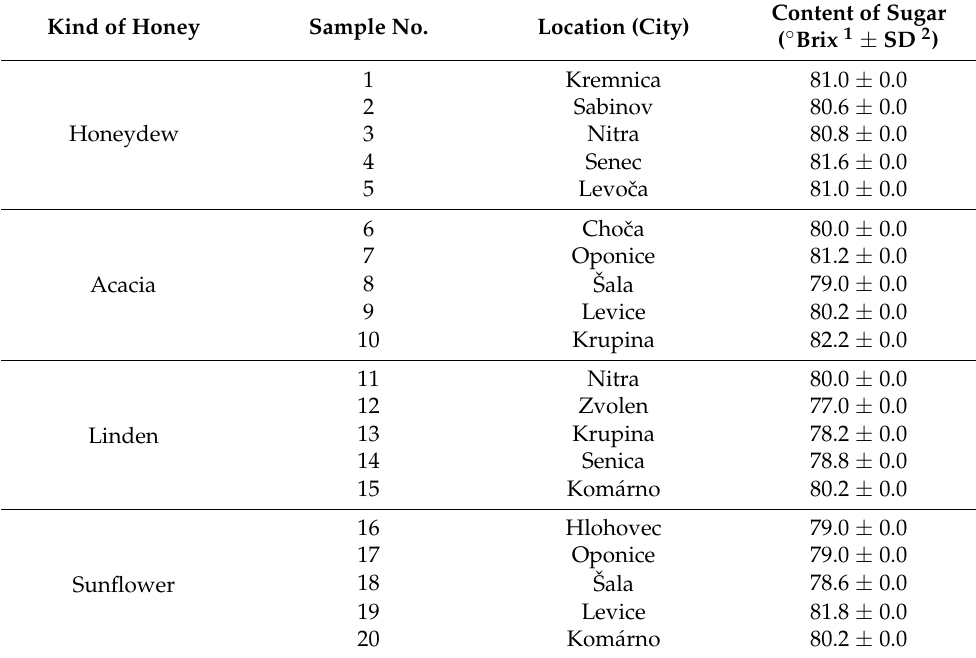
Table 1. Basic characterization of Slovak honey samples, including kind of honey, location, and sugar content. Kind of Honey Sample